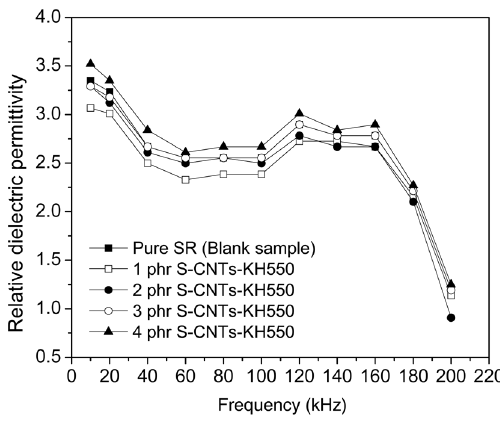
Figure 5 Relative dielectric permittivity of S-CNT-KH550/SE com- posites with different frequencies of outer electric